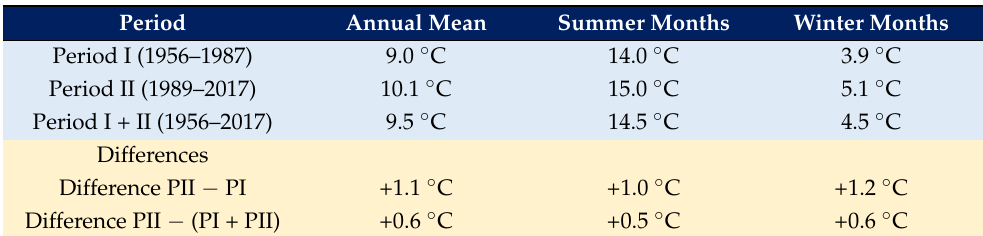
Table 1. Annual temperature means over 60 years (1956–2018) comparison of phase II (1988–2018) versus phase I